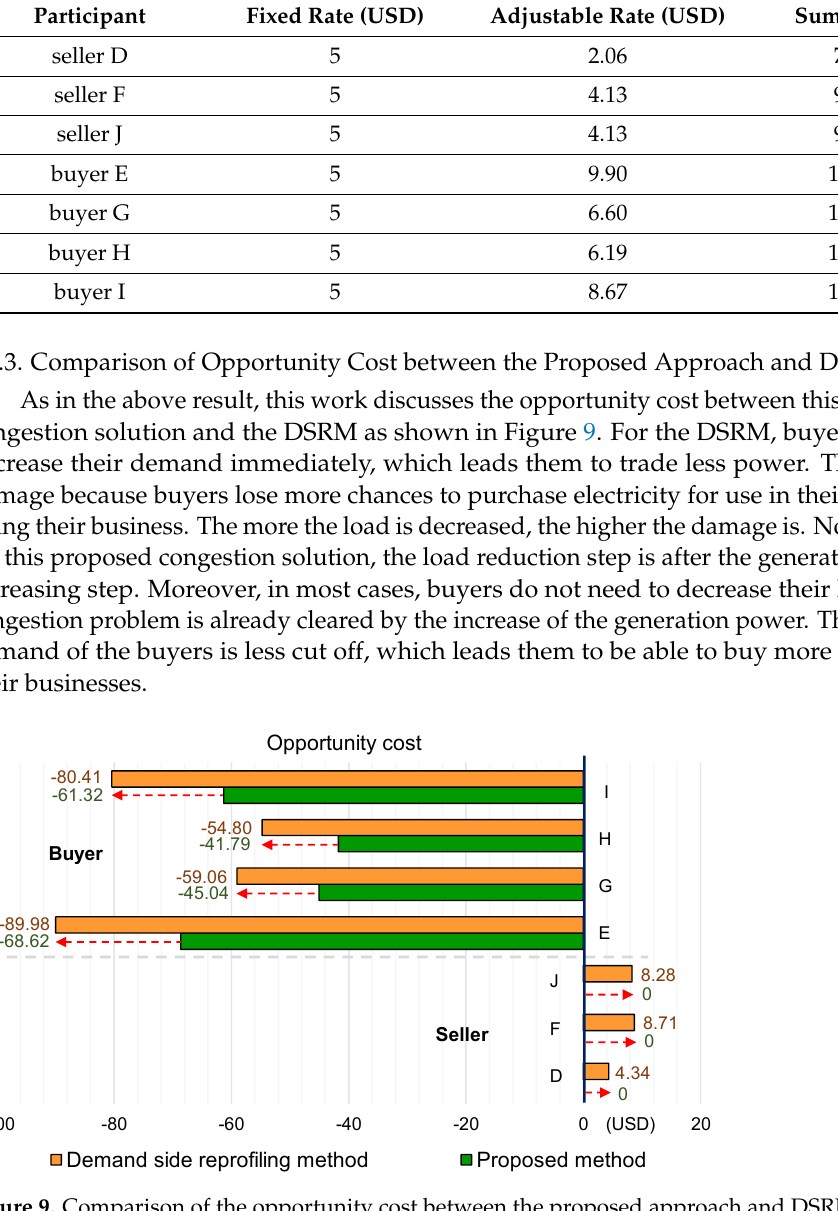
Figure 9. Comparison of the opportunity cost between the proposed approach and DSRM .